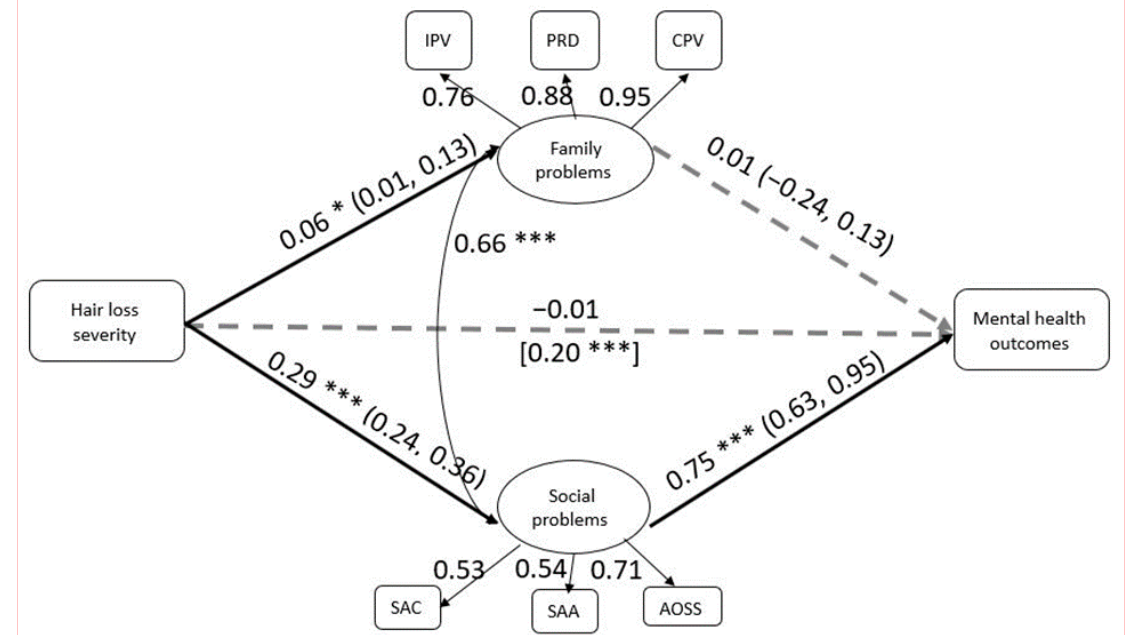
Figure 1. The mediation model. Note. IPV = intimate partner violence; PRD = parent–child relationship difficulties; CPV = child-to-parent violence; SAC = social abuse during childhood; SAA = social abuse during adulthood; AOSS = avoidance of social situations. * p < 0.05, *** p < 0.001. Solid lines mark significant paths, and dashed lines mark nonsignificant paths. Value in brackets refer to the total effect of hair loss on mental health (i.e., before the mediation). Values in parentheses refer to 95% confidence intervals for the mediation paths.